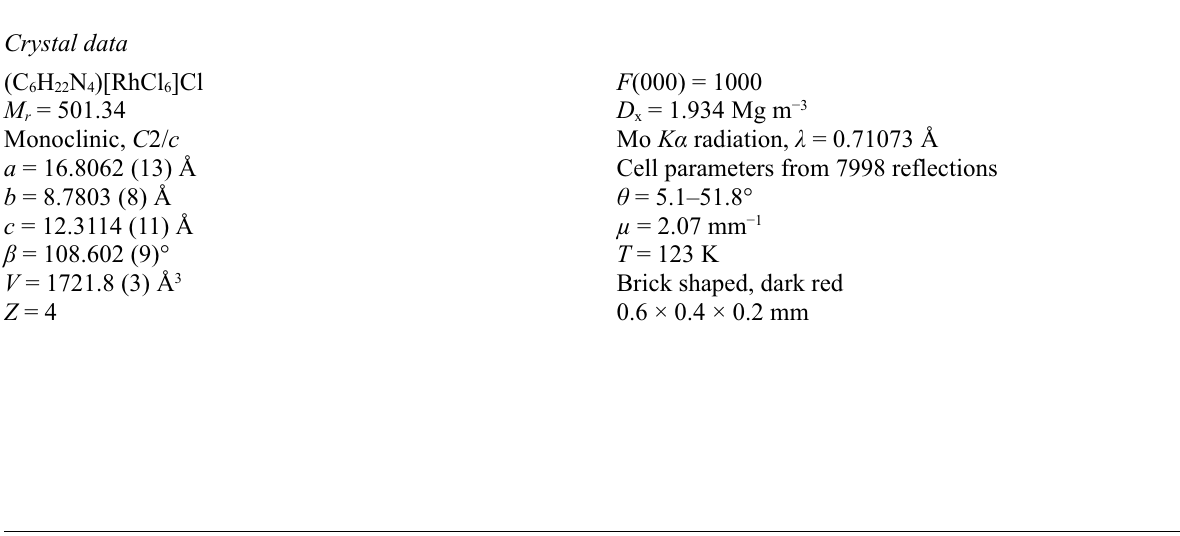
sup-5 Acta Cryst. (2008). E 64 , m257